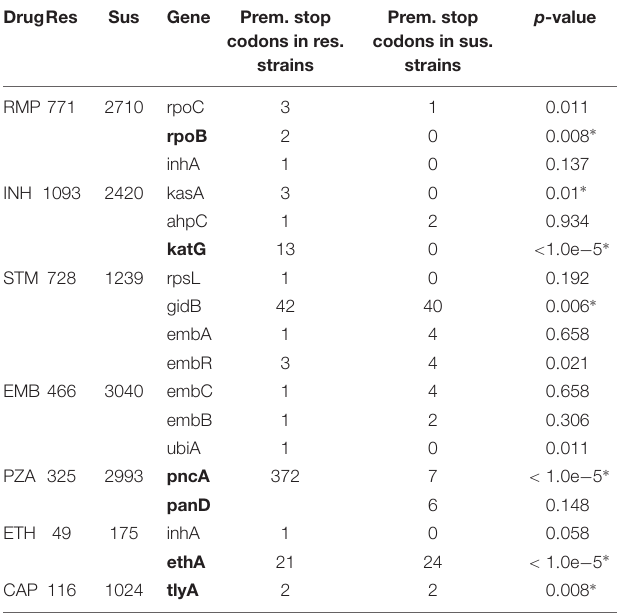
TABLE 3 | Occurrence of resistance-associated genes with premature stop codons in resistant or susceptible strains in the ReSeq data set. DrugRes Sus Gene Prem. stop Prem. stop codons in res. codons in sus.